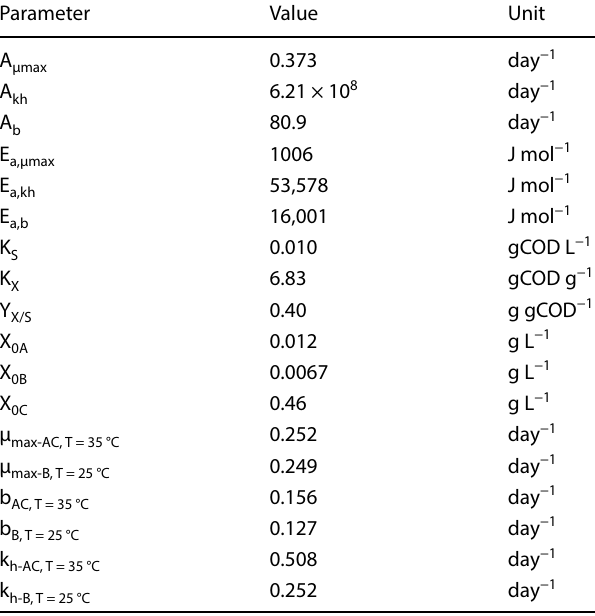
Table 3 Values of kinetics parameters calculated for the model